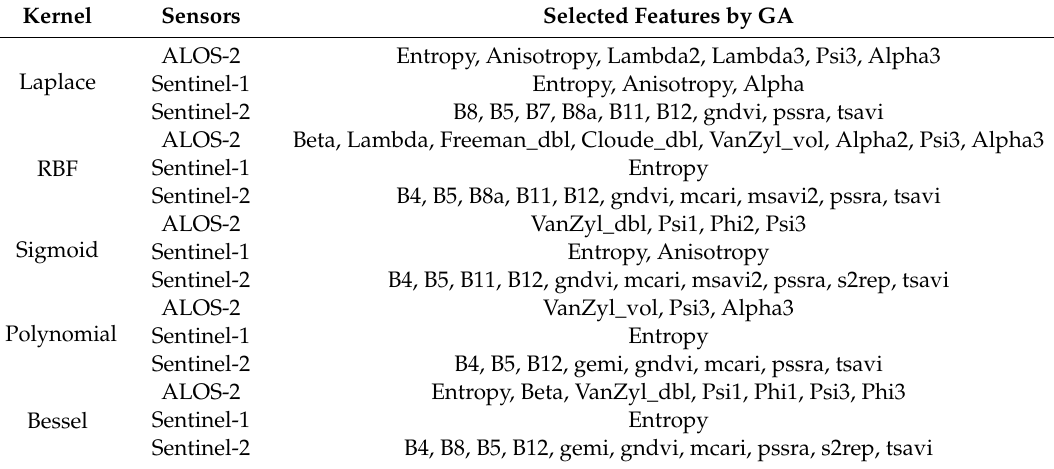
Table 11. Selected features for kernels by